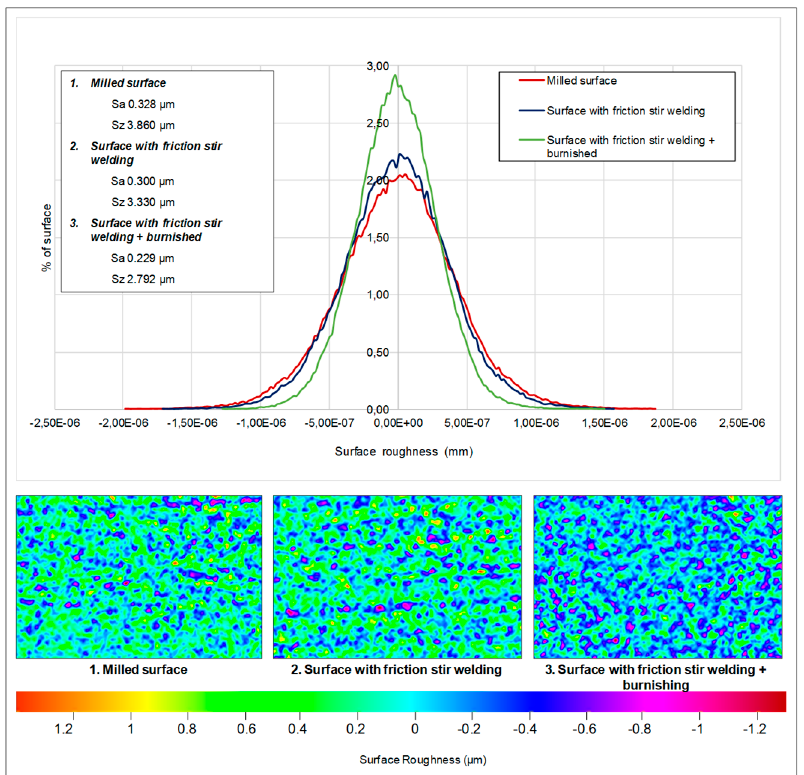
Figure 16. Measured roughness